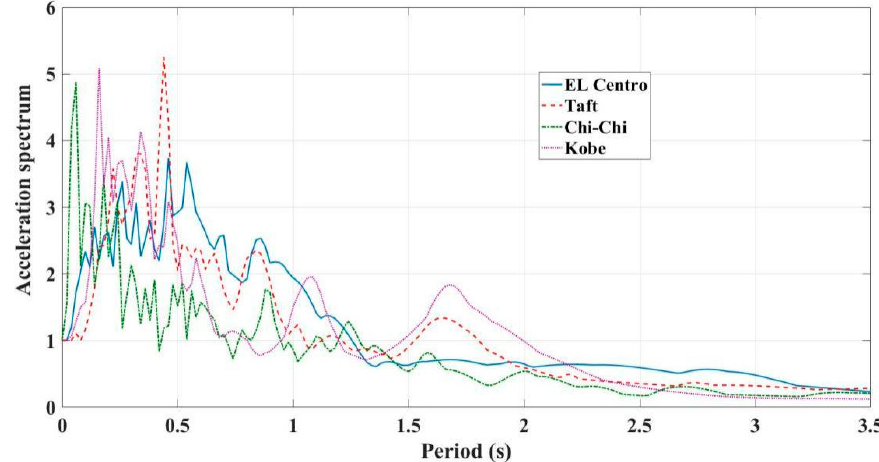
Figure 18. Normalized acceleration spectra of ground motion records.